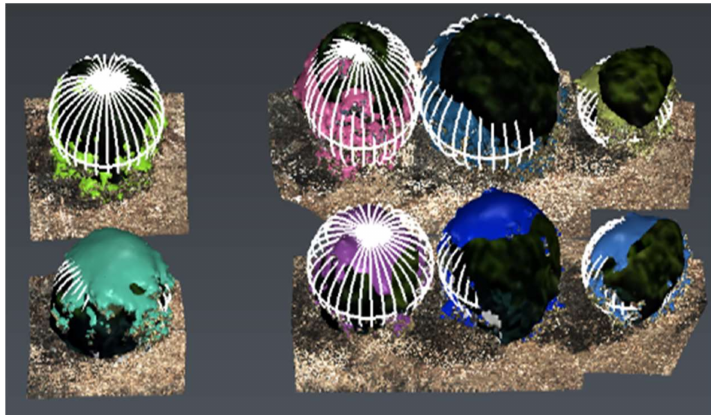
Figure 14. Overlapping of models created with